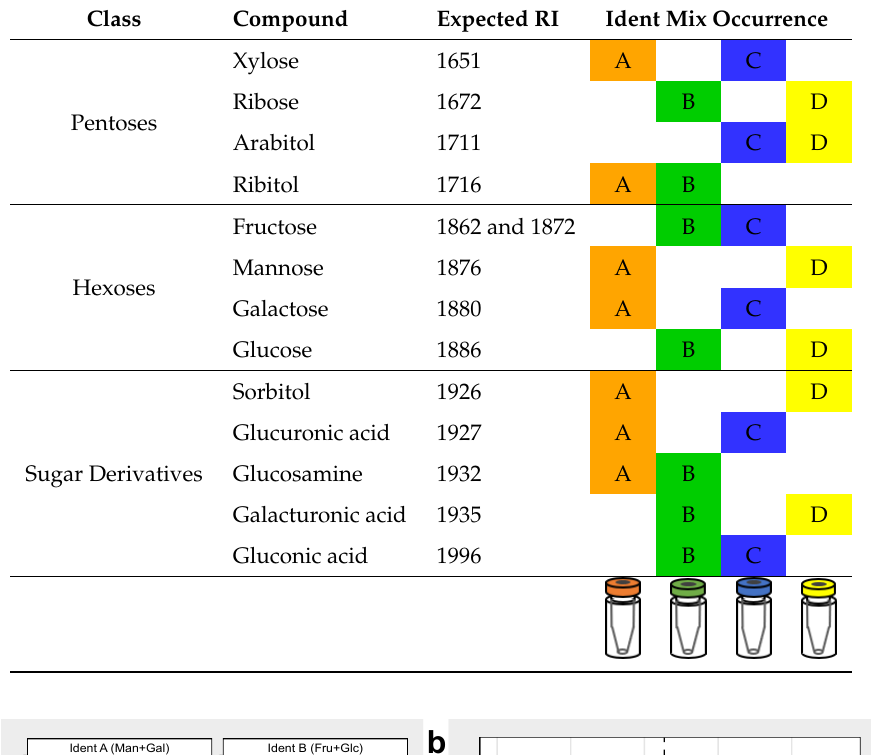
Table 2. Composition of the Ident-Mix (excerpt from Table S7). Shown are three different metabolite classes with potential identification problems based on compound and RI similarity. Most metabolites generate two peaks due to multiple derivatisation products, often with the second peak lower abundant. However, for fructose both peaks have nearly the same intensity (Figure4a,b), so we list the RI for both peaks here. Colors are given to illustrate appropriately the same colour scheme as used in Figure4.